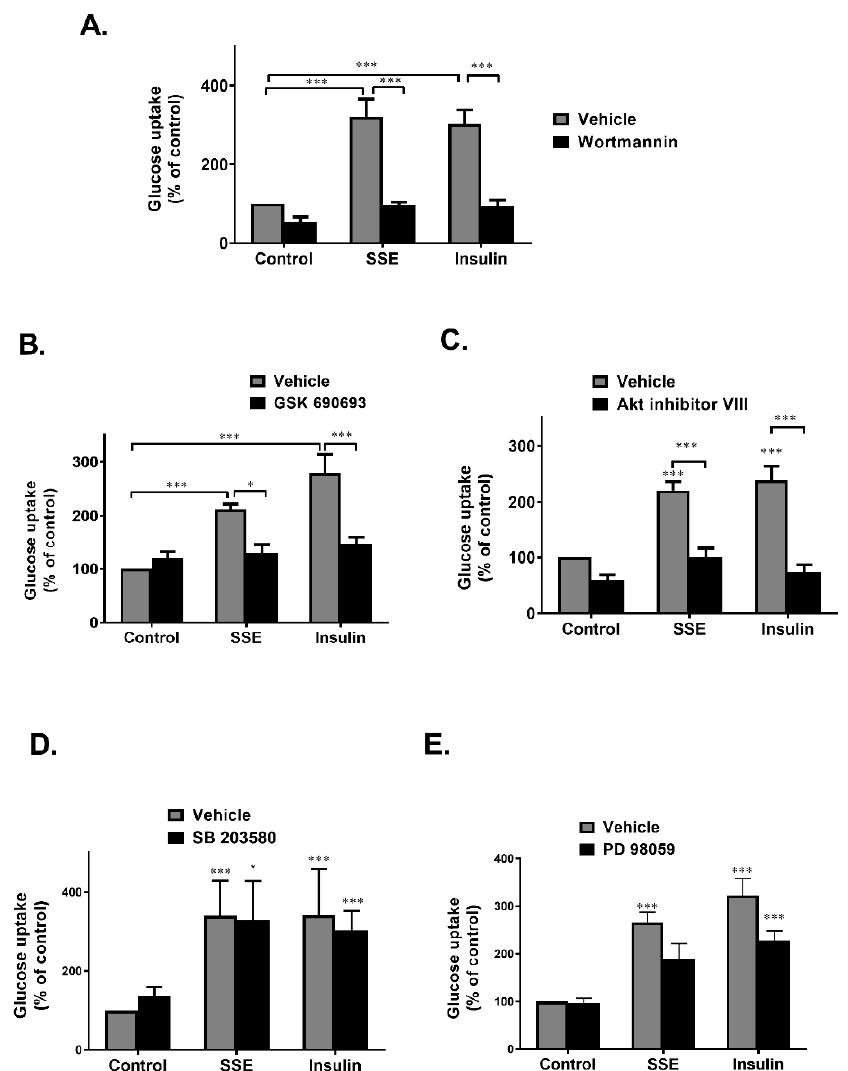
Figure 5. PI3K-Akt pathway is required to activate SSE-dependent glucose uptake. Differentiated 3T3-L1 adipocytes were treated with SSE (70 µg/mL) with the use of insulin (100 nM) as a positive control, with or without 30 min pretreatment with 100nM wortmannin ( A ), 1 µM GSK690693 ( B ), 5 µM Akt inhibitor VIII ( C ), 50 µm PD 98059 ( D ), or 10 µM SB 2035810 ( E ). The uptake of [3H]2-Deoxy-D-glucose into cells was determined as described in Materials and Methods. Data are expressed as percent of basal uptake in control cells. The data represent the mean ± SE of measurement made on six replicates in each of at least four independent experiments. * p < 0.05, and *** p < 0.0005, analyzed by one-way ANOVA, followed by Bonferroni’s post-hoc testing.